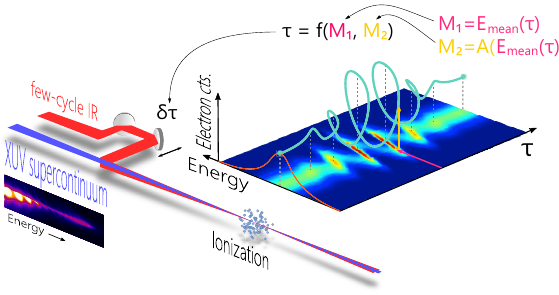
Figure 1. Principle of LIZARD-IAP. A feedback loop is per- formed in order to stabilize the XUV / IR delay τ , whose inputs are two quantities extracted from the streaked photoelectron spec- trum: the mean energy ( M 1 ( τ ), vivid pink arrow) and the ampli- tude at this energy ( M 2 ( τ ), yellow arrow). If the XUV pulse is chirped, the correlation of these two quantities draws an ellipse (cyan curve). The delay τ can be reconstructed unambiguously, and any variation from the set-point value is compensated using two mirrors mounted on a piezo-electric stage. The streaking trace used in the figure is extracted from